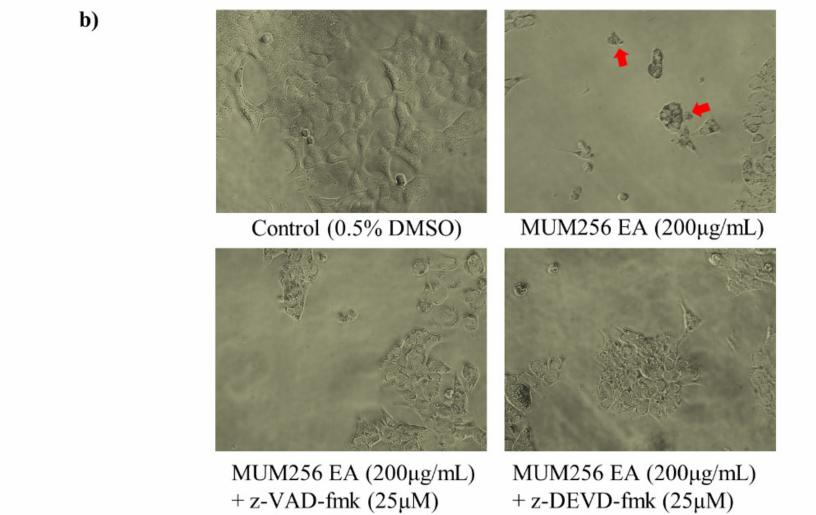
Figure 7. Effect of caspase inhibitors on MUM256 EA induced apoptosis in HCT116 cells. ( a ) Cells were pretreatedwitheitherz-VAD-fmk(25 µ g / mL)orz-DEVD-fmk(25 µ g / mL)for1h, thentreatedasdescribed (Control—0.5% DMSO, with or without—200 µ g / mL MUM256 EA) for 24 h. Cell viability was